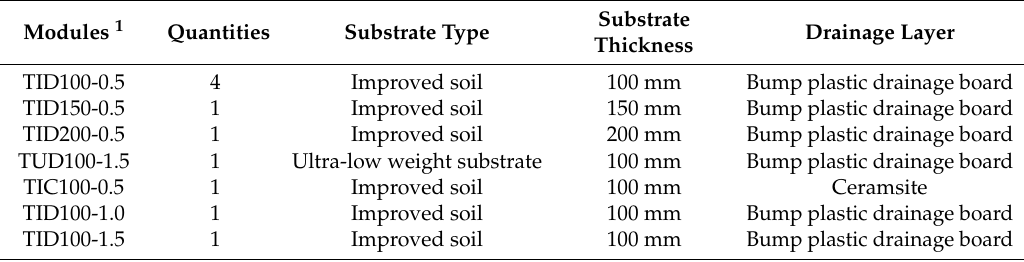
Table 1. Detailed information of the 10 extensive green roof (EGR) modules monitored and analyzed in the study.